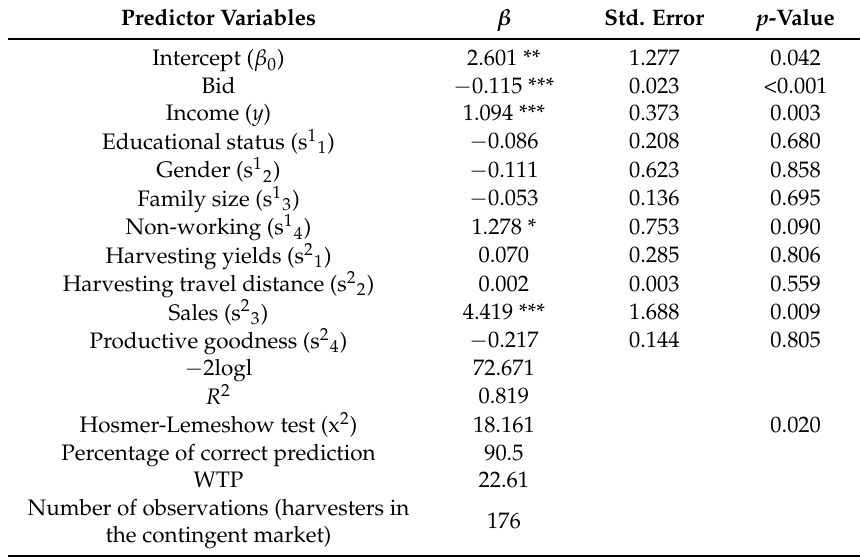
Table 4. Estimation results of logistic regression WEMHP model (predicted variable WTP). Predictor Variables β Std. Error p